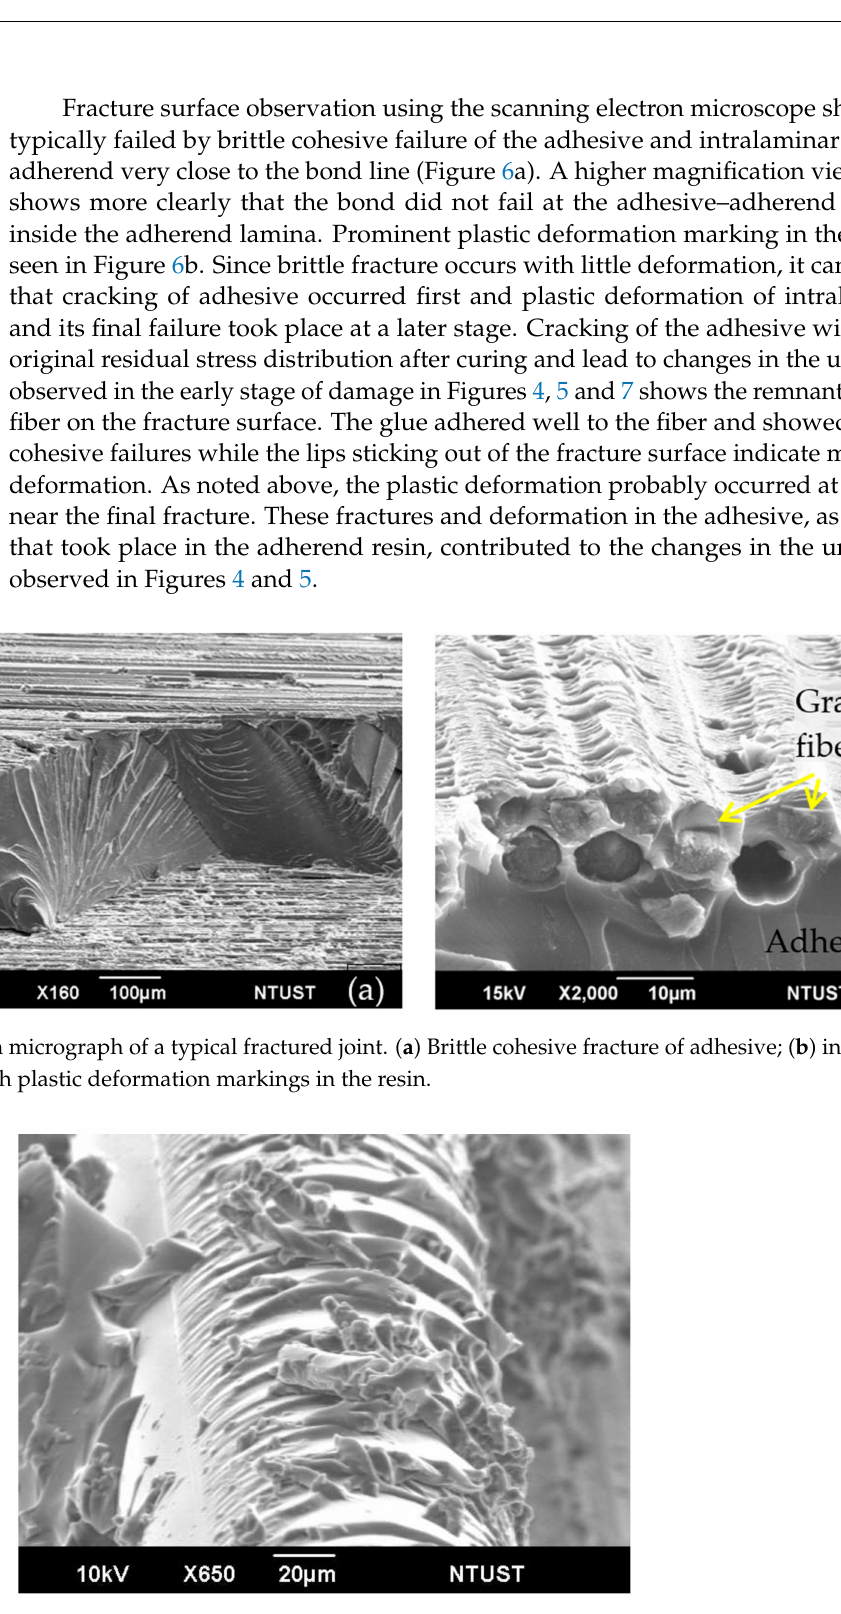
Figure 7. Scanning electron micrograph showing the embedded optical fiber on the fractured